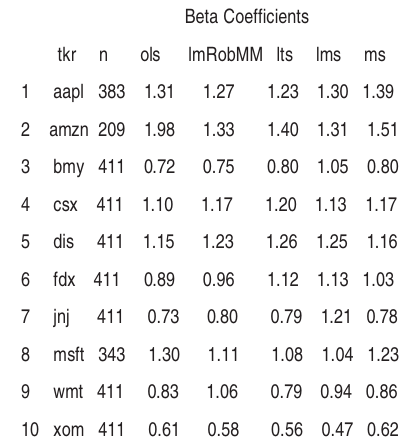
Table 1. Beta coefficients for ten large companies